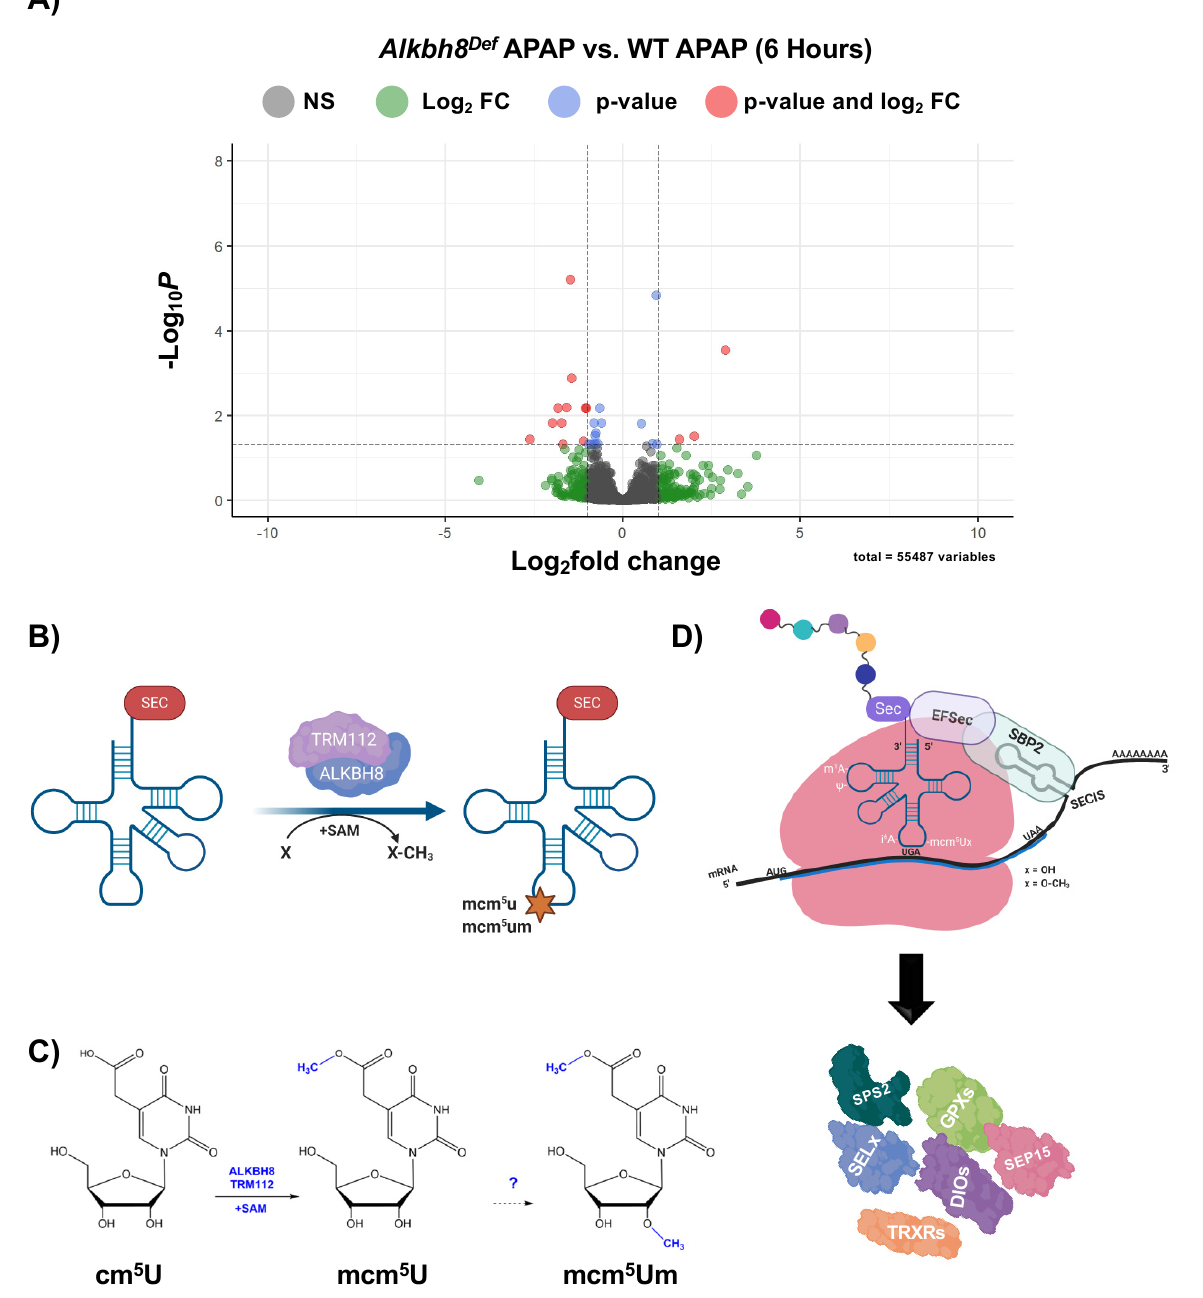
Figure 3. WT and Alkbh8 Def livers have a similar transcriptional response to a single dose of APAP. mRNA-seq data for ( A ) Alkbh8 Def APAP vs. WT APAP was compared using an enhanced volcano plot. ( B ) Post-transcriptional regulation of translation by Alkbh8 and epitranscriptomic marks. Alkbh8 requires the small accessory protein Trm112 and S-adenosylmethionine (SAM) to modify the wobble position of tRNA Sec ( C ) from cm 5 U to mcm 5 U, which is then further modified to the ri- bose-methylated derivative mcm 5 Um. ( D ) Stop-codon recoding utilizes mcm 5 U and mcm 5 Um in tRNA Sec to decode UGA to produce selenoproteins. In addition to Alkbh8-catlyzed epitran- scriptomic marks, elongation factors, a selenocysteine insertion sequence (SECIS), accessory pro- teins, and an internal UGA stop codon are used to promote the translation of selenocysteine con- taining proteins.